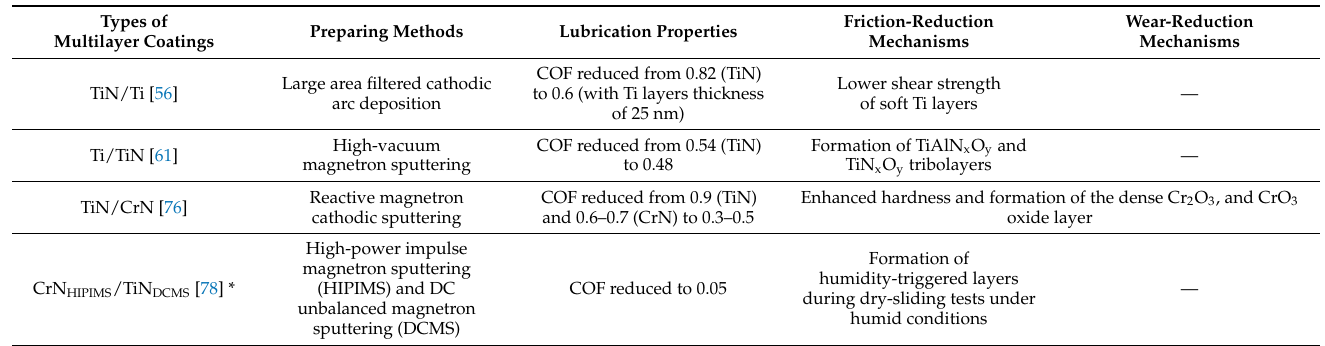
Figure 9. Schematic diagram of the mechanisms of the multilayer designing of coating. ( a ) Crack deflection and stress relaxation in multilayer coating. Reprinted with permission from [39]. ( b ) Theoretical constitution of supporting interlayers of DLC coating. Reprinted with permission from [45]. Table 1. Friction and wear-reduction mechanisms of multilayer